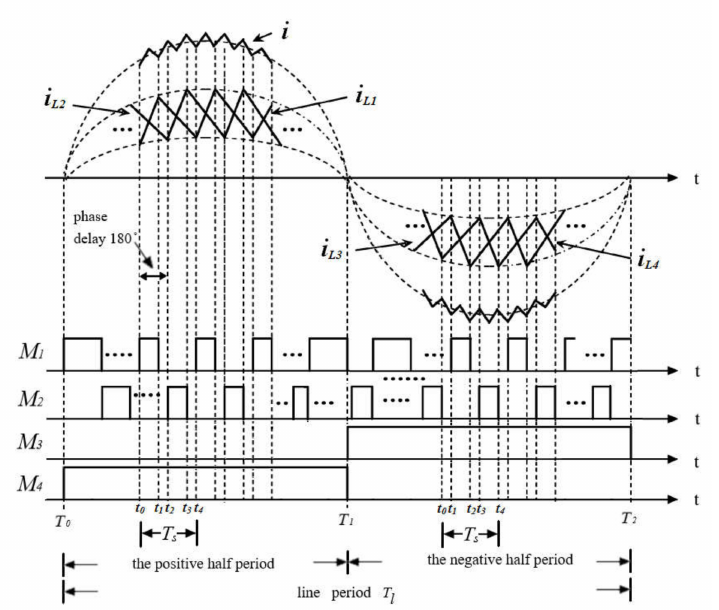
Figure 7. Conceptual waveforms of the proposed interleaving bridgeless boost converter during a complete line